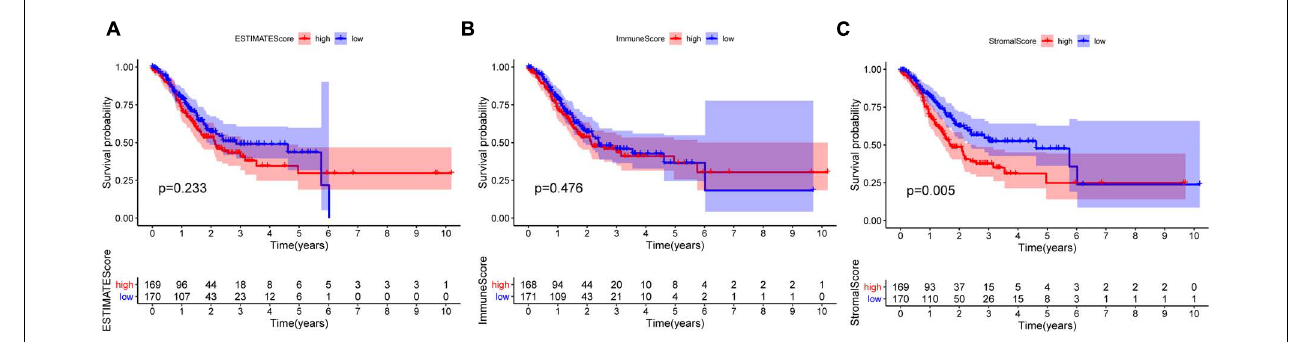
FIGURE 4 | Correlation of each estimate, immune, and stromal score with the survival outcome of patients with gastric cancer (A–C) .